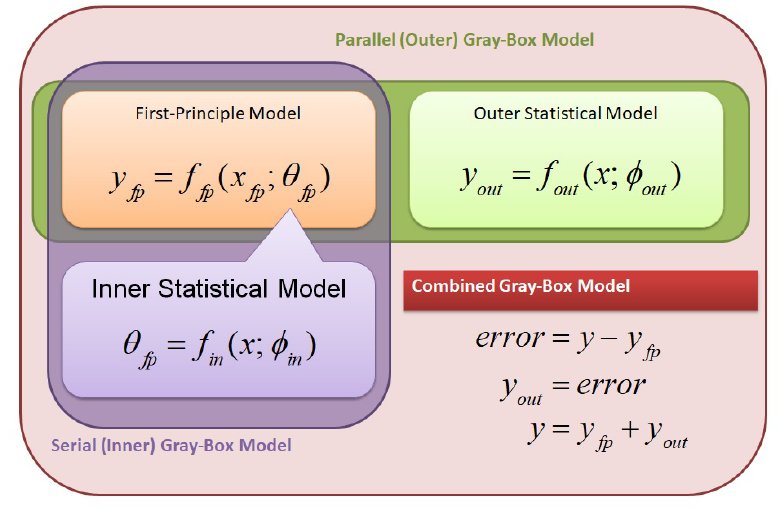
Figure 1. Generalized framework grey-box (GB) modeling